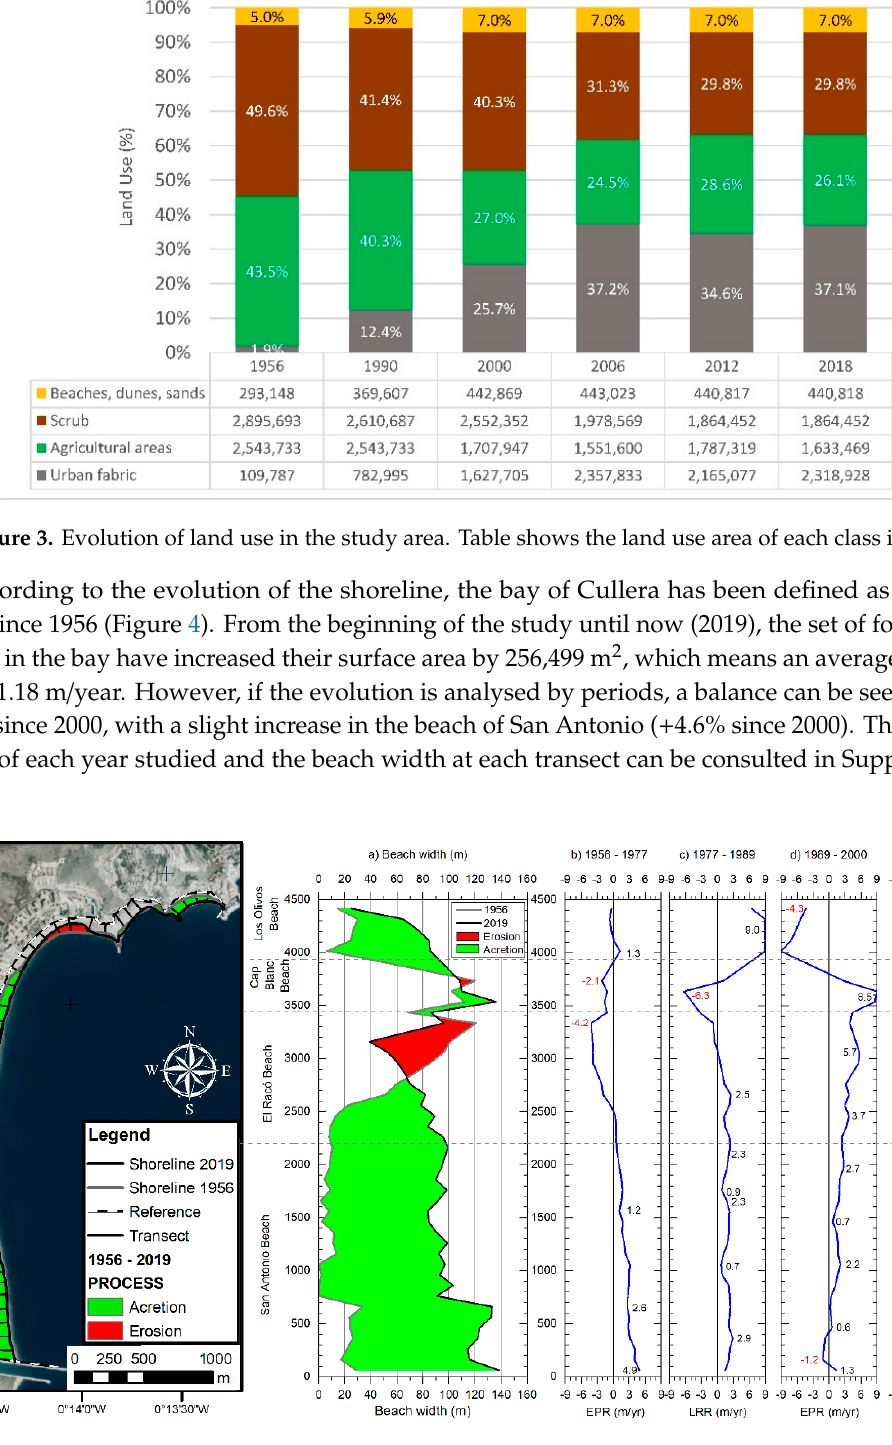
Figure 4. ( a ) Beach width for each transect in 1956 and 2019. ( b ), ( c ), ( d ) and ( e ), Linear regression rates (LRR) for each period of study in m/yr. Since the periods 1956–1977 and 1989–2000 are each composed of only two dates, End Point Rates (EPR) were presented.